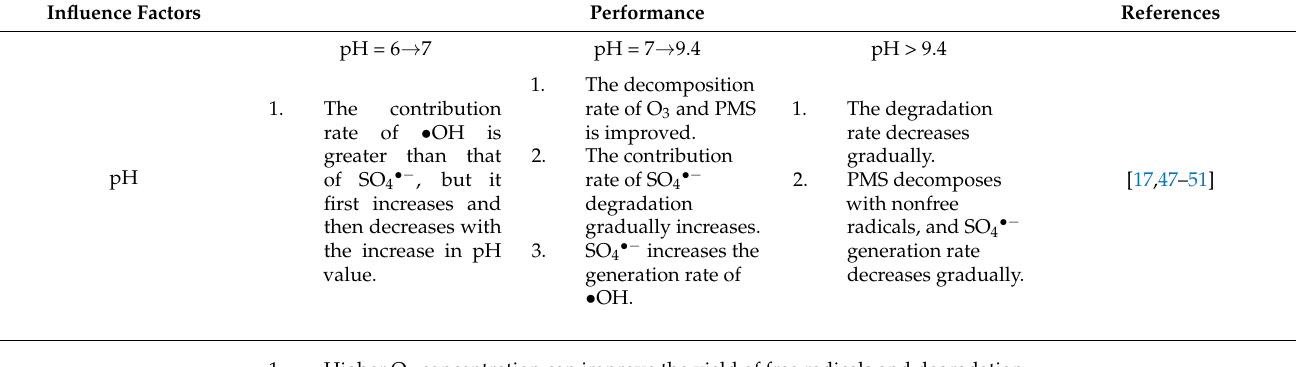
Table 4. The main influencing factors in the O 3 /PMS